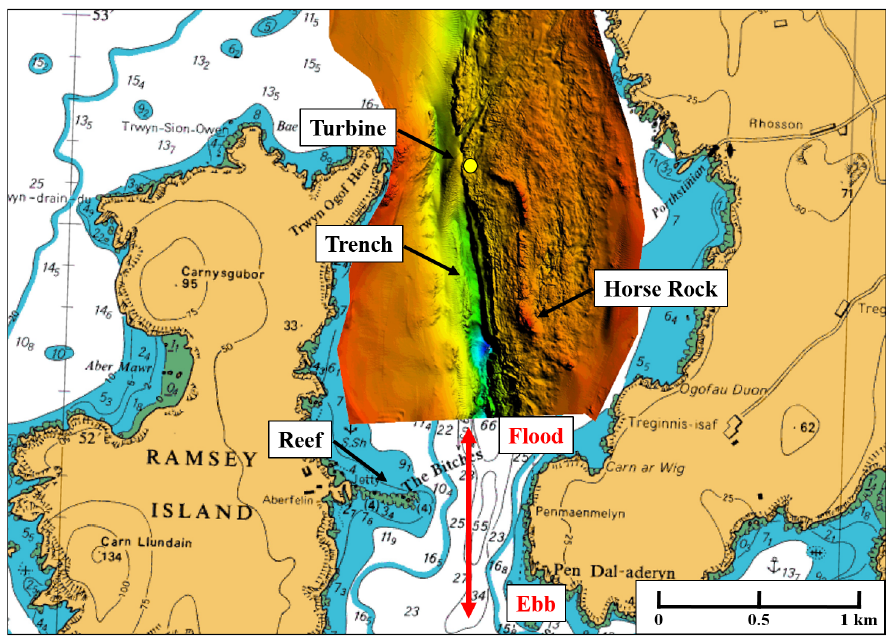
Figure 1. Map showing the turbine location within Ramsey Sound and the site